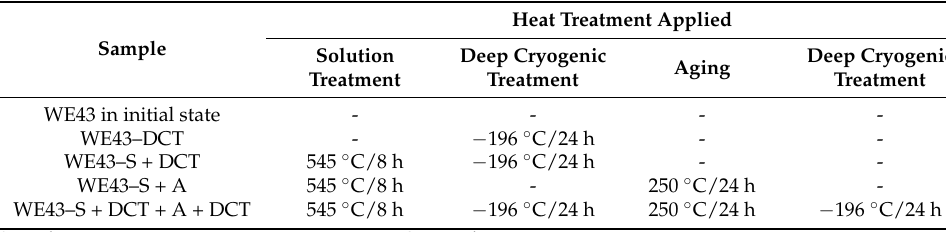
Table 2. Summary of heat treatment applied to WE43